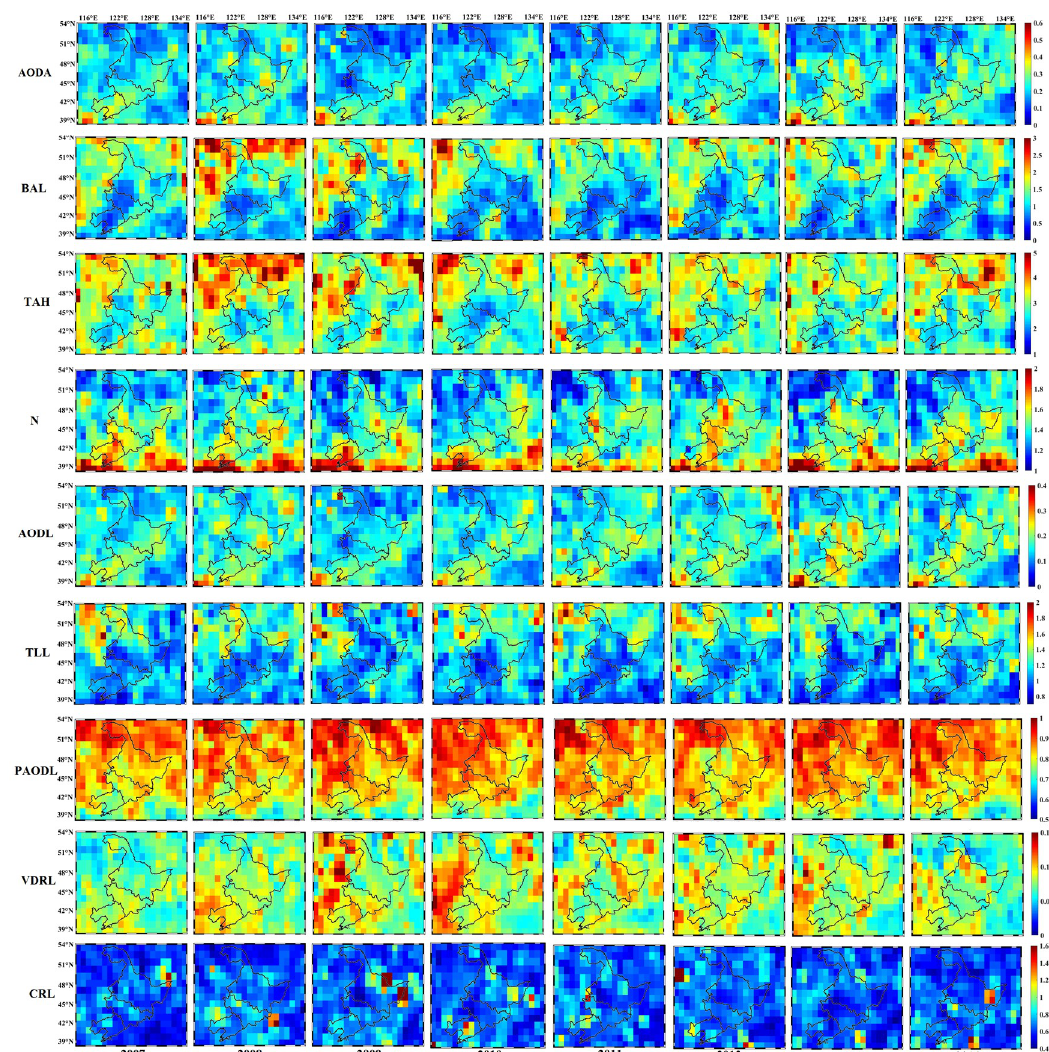
Figure 4. Inter-annual spatial distributions of AODA, BAL, TAH, N, AODL, TLL, PAODL, VDRL, Figure 4. Inter‐annual spatial distributions of AODA, BAL, TAH, N, AODL, TLL, PAODL, VDRL, and CRL over NEC (HLJ, JL, and LN) in the daytime, from 2007 to and CRL over NEC (HLJ, JL, and LN) in the daytime, from 2007 to 2014.